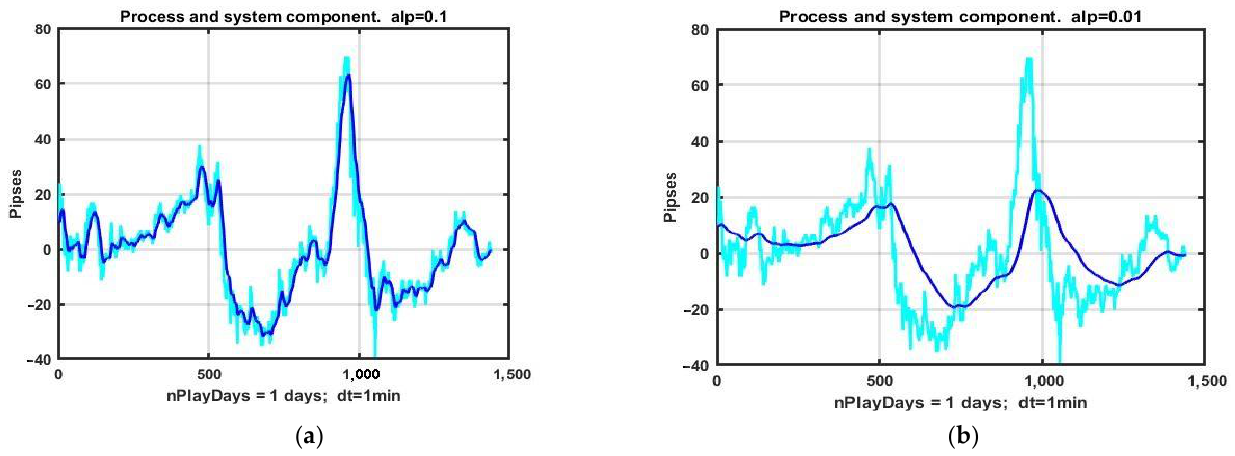
Figure 9. System component selection using an exponential filter with coefficients α = 0.1 ( a ) and α = 0.01 ( b ).